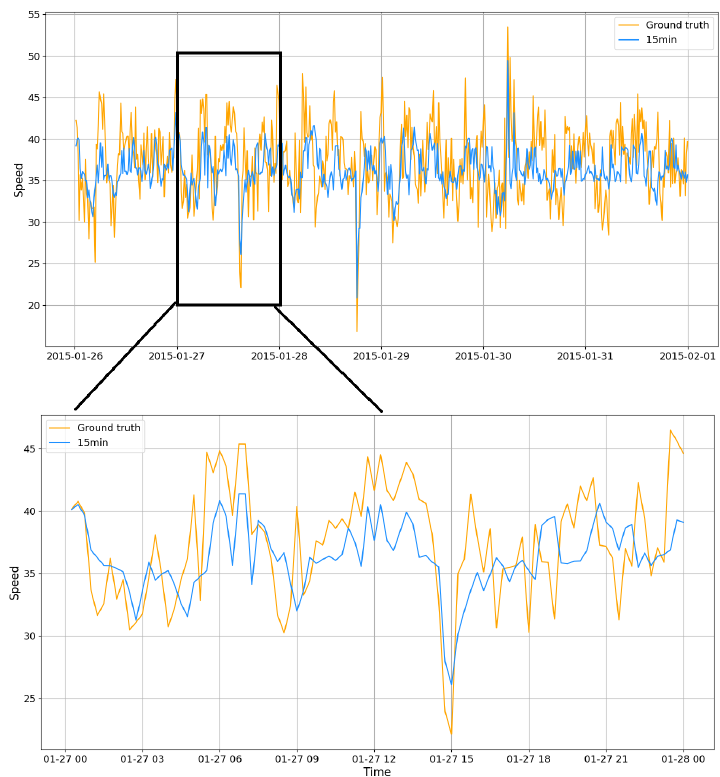
Figure 7. Result for prediction horizon of 15